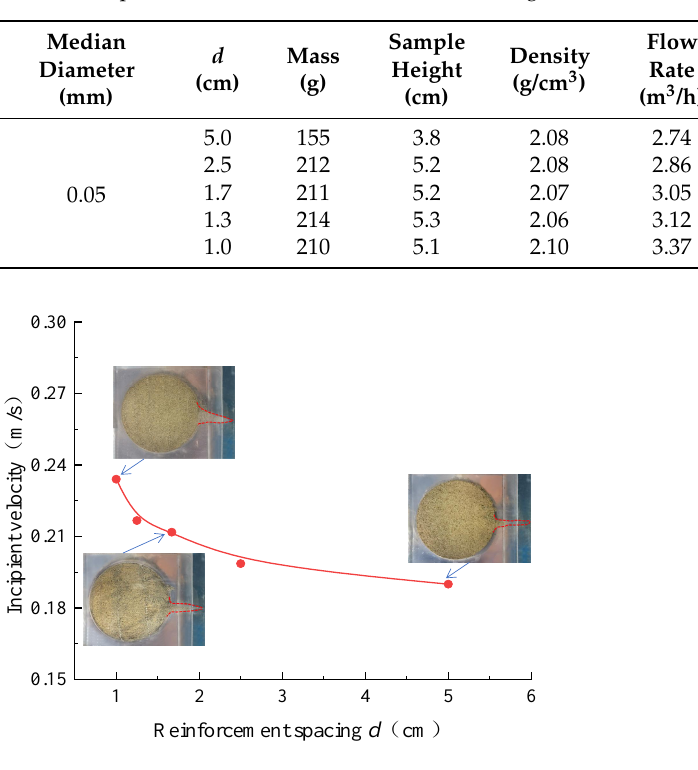
Table 1. Incipient motion test data of reinforced tailings.